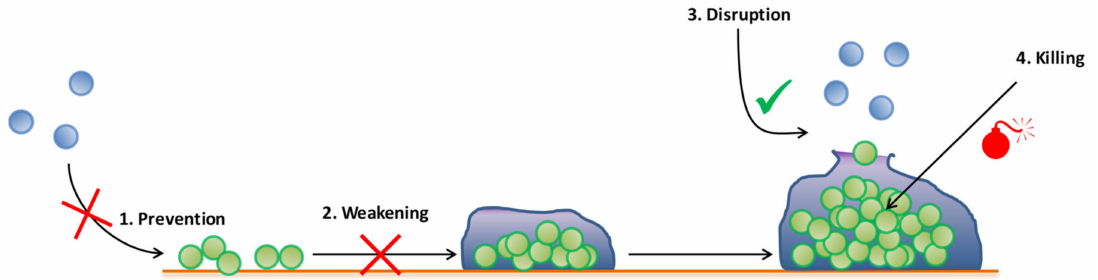
Figure 3. Summary of di ff erent ways to fight biofilm during its